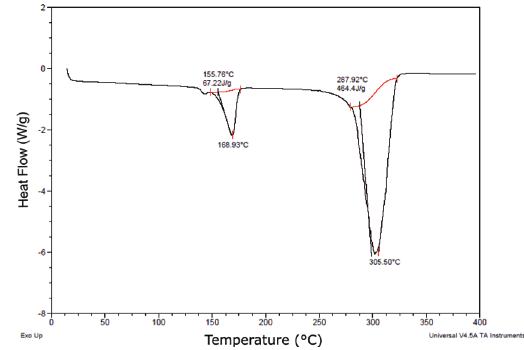
Figure 3: DSC curve of PHB up to 400 °C, before